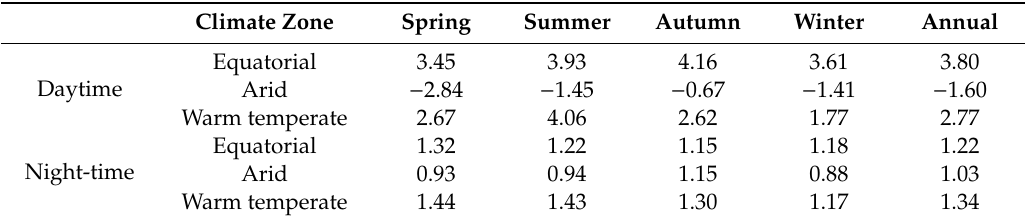
Figure 4. The night-time SUHII values for each city in South America. Table 2. The diurnal and seasonal surface urban heat island intensity (SUHII, ◦ C) in di ff erent climate zones of South America.